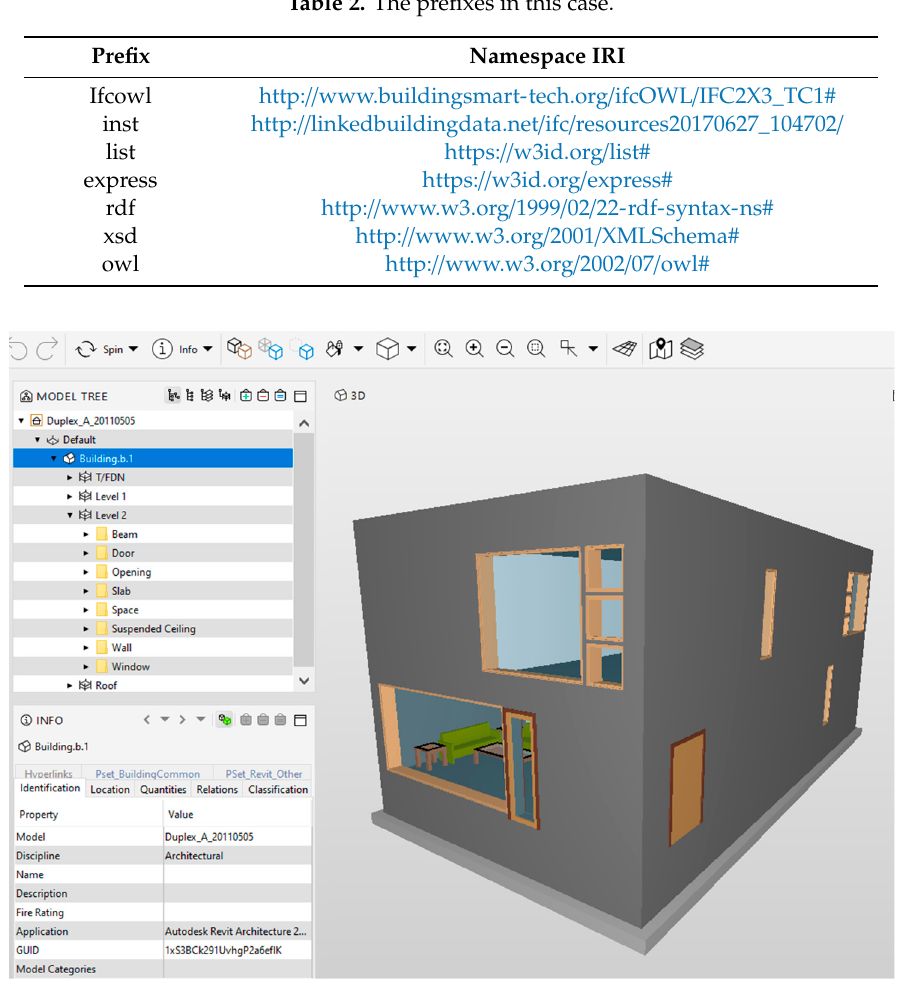
Table 2. The prefixes in this case.